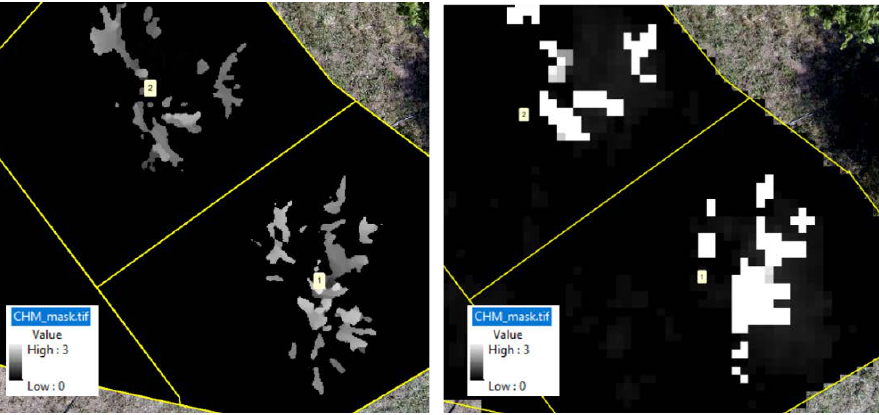
Figure 5. Canopy height model generated using the T1 (Pix4D) and T2 (point sampling) approaches.